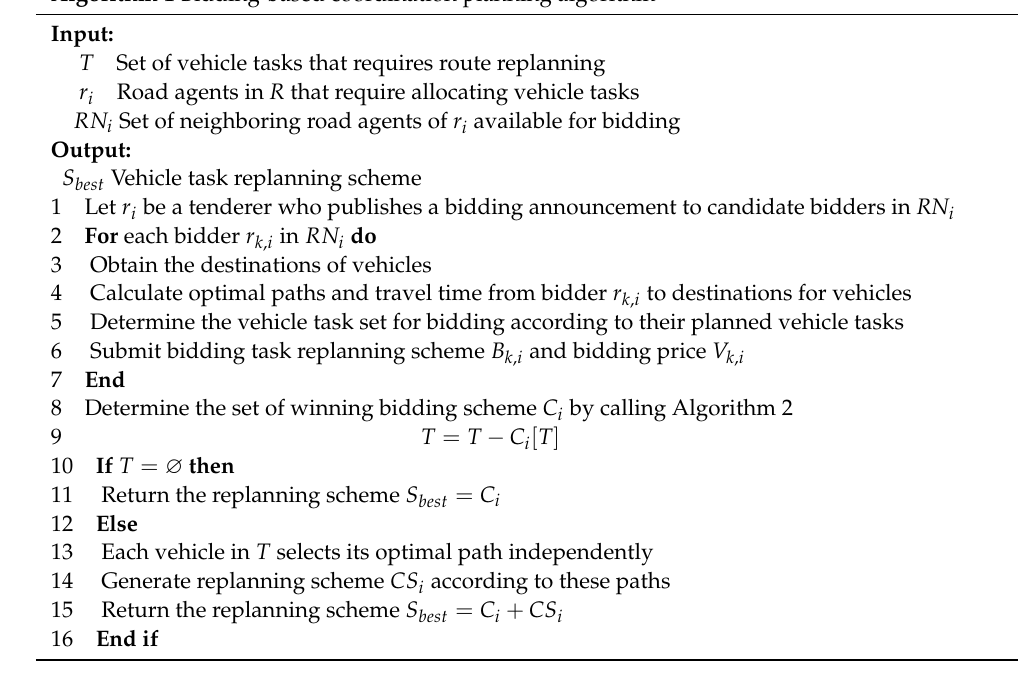
Algorithm 1 Bidding-based coordination planning